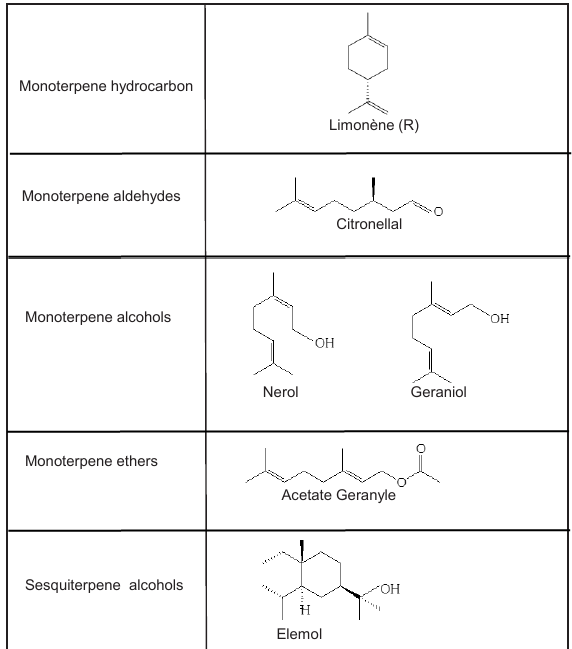
Figure 2: Chemical structures of the major compounds found in the analyzed Cymbopogon nardus essential